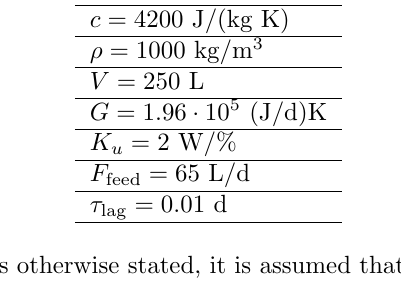
Table 6: Parameters of reactor temperature